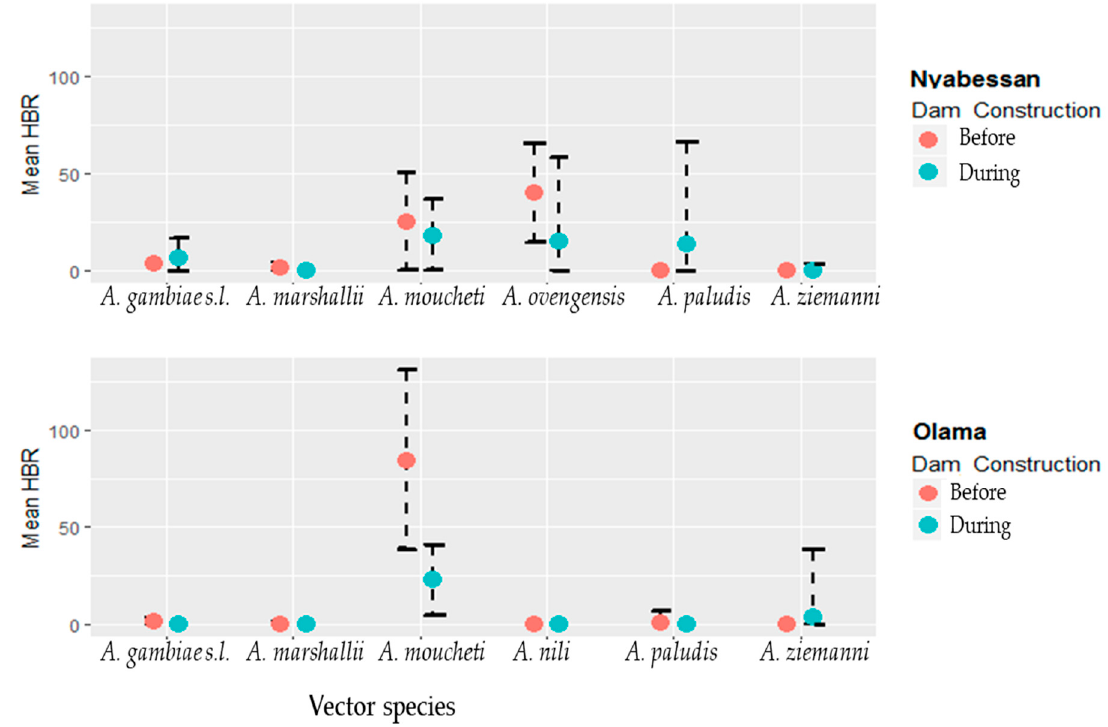
Figure 3. Mean night human biting rates (HBR) of six major anopheline species in Nyabessan and Olama before and during dam construction.